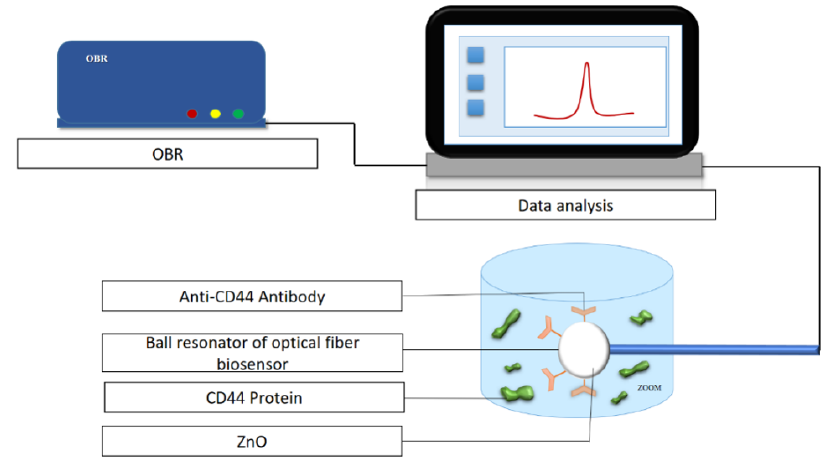
Figure 1. Experimental setup for the detection of the CD44 protein using a biofunctionalized sensor.